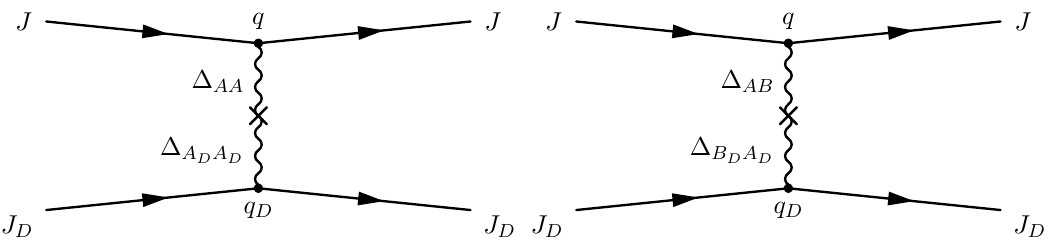
Figure 1 . The two diagrams describing the interaction between visible and dark electric currents. Scattering proceeds through A - A D mixing (left) and B - B D mixing